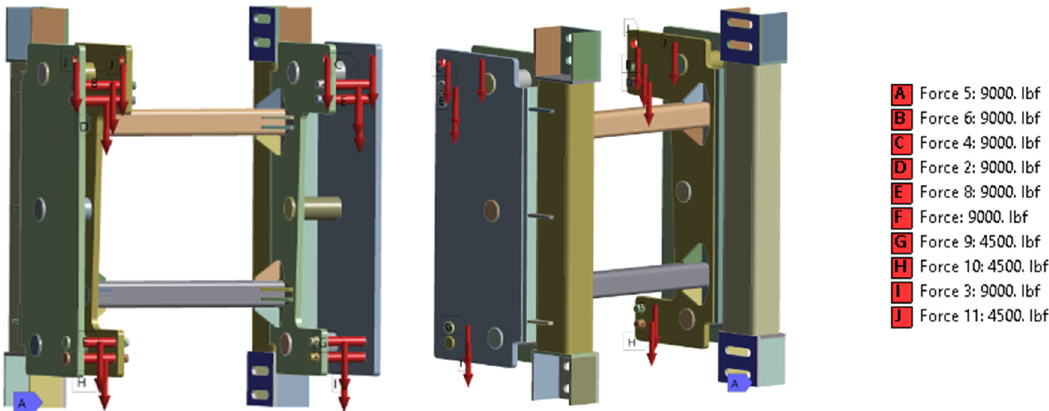
Figure 5: Load and boundary conditions for load case